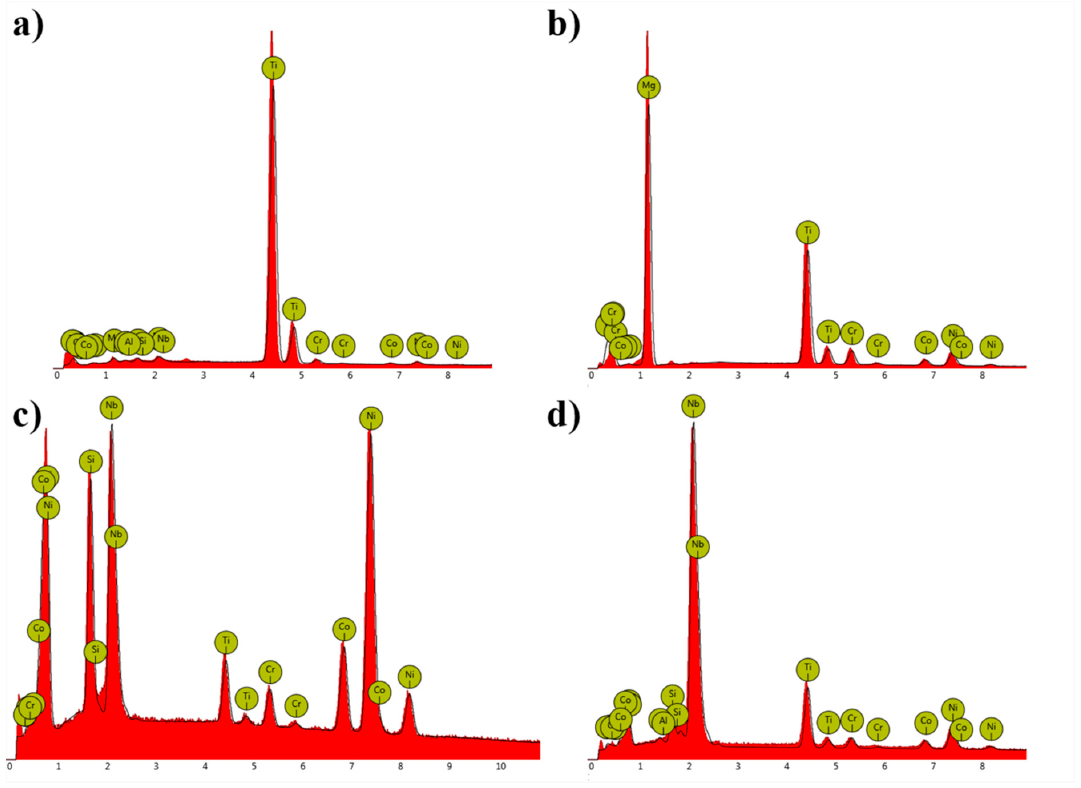
Figure 8. EDS spectra of detected precipitates: ( a ) TiN; ( b ) MgO; ( c ) Si-rich phase; ( d ) (Nb,Ti)C.